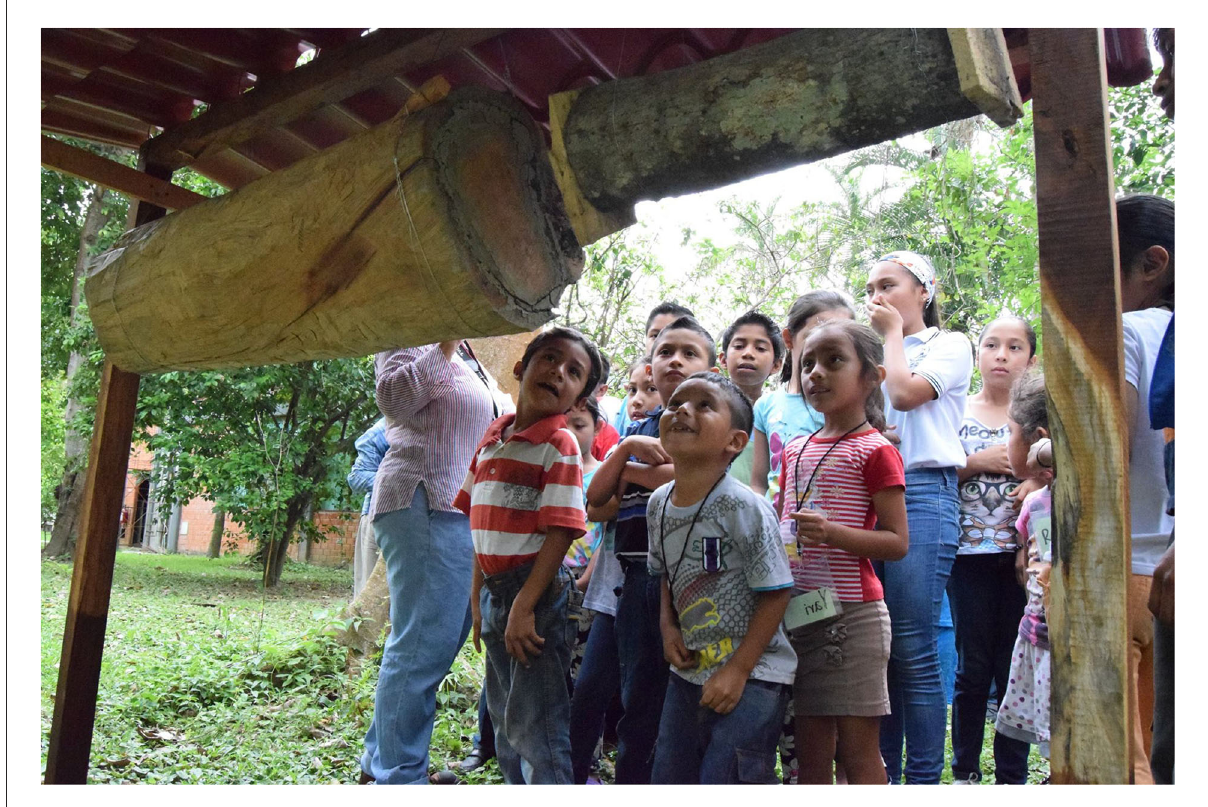
FIGURE4 Guided visit at the meliponary of ECOSUR